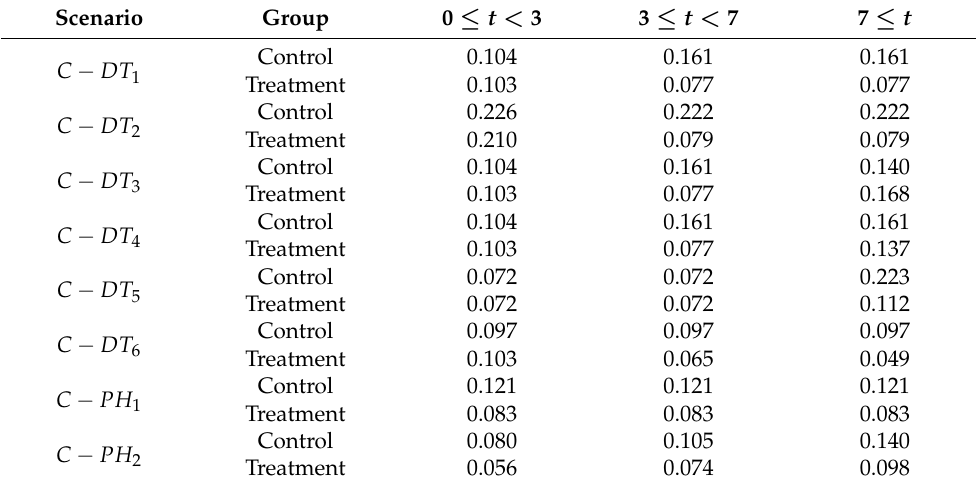
Table 5. Hazard functions of scenarios in clinical trial settings.